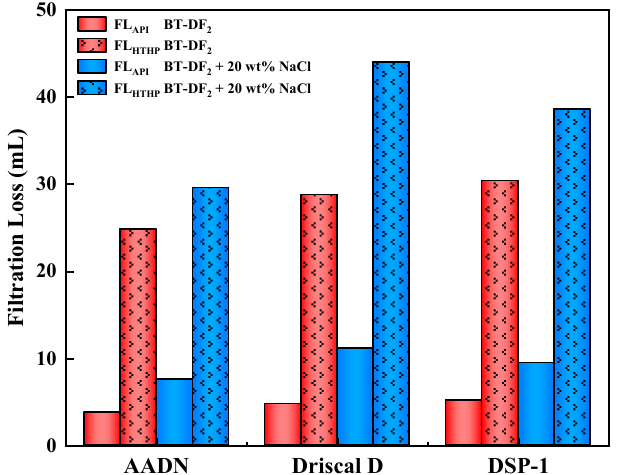
Figure 11. Filtration volume of different filtration loss reducers in BT-DFs (after aging at 200 °C for 16 h).